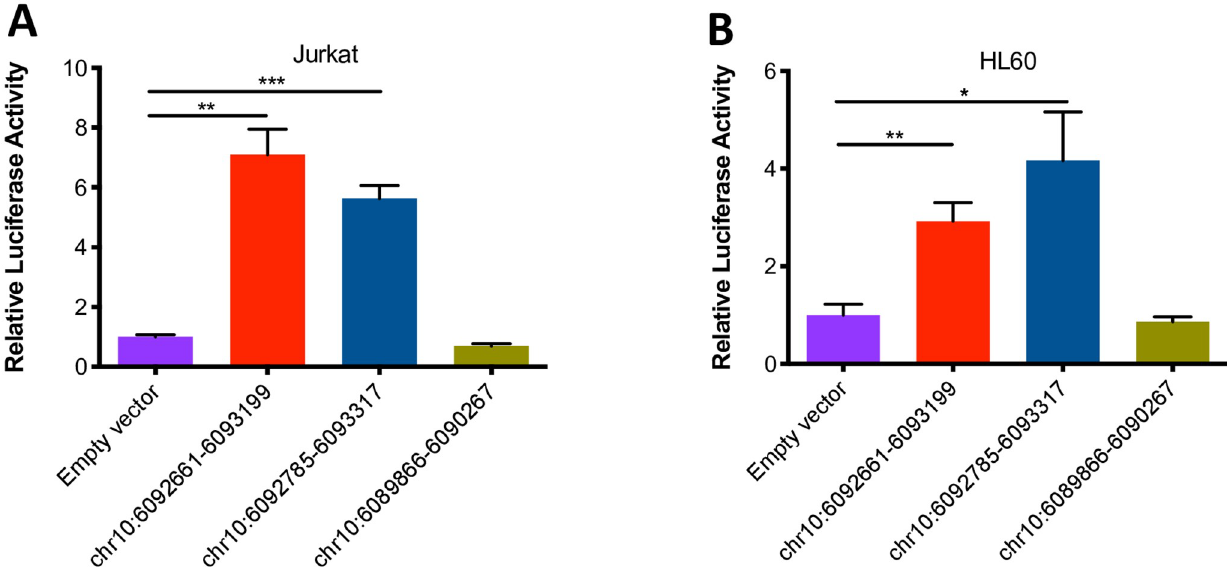
Fig 4. Summary of results from luciferase assays assessing enhancer activity at the IL2RA locus in Jurkat T cells and HL60 cells. A and B. The results are from 539bp and 533 constructs, respectively, with the constructs tiled across an H3K4me1/H3K27ac-marked region within JIA-associated haplotype in the first intron of the IL2RA gene. Chromosome coordinates for each construct are indicated beneath each bar. Both constructs showed enhancer activity in Jurkat T cells (A) and in HL-60 cells (B). Note that the bar on the far right shows results from the region that includes the index SNP rs7909519. This region does not show enhancer activity. The empty vector (negative control) is the basic pGL4.23 vector (which contains the SV40 promoter but is inefficient at driving luciferase expression). Data are represented as mean ± SEM of 3 (A) or 4 (B) biological replicates, and p values are calculated using Student’s t test. � p � 0.05; �� p � 0.01; ��� p �